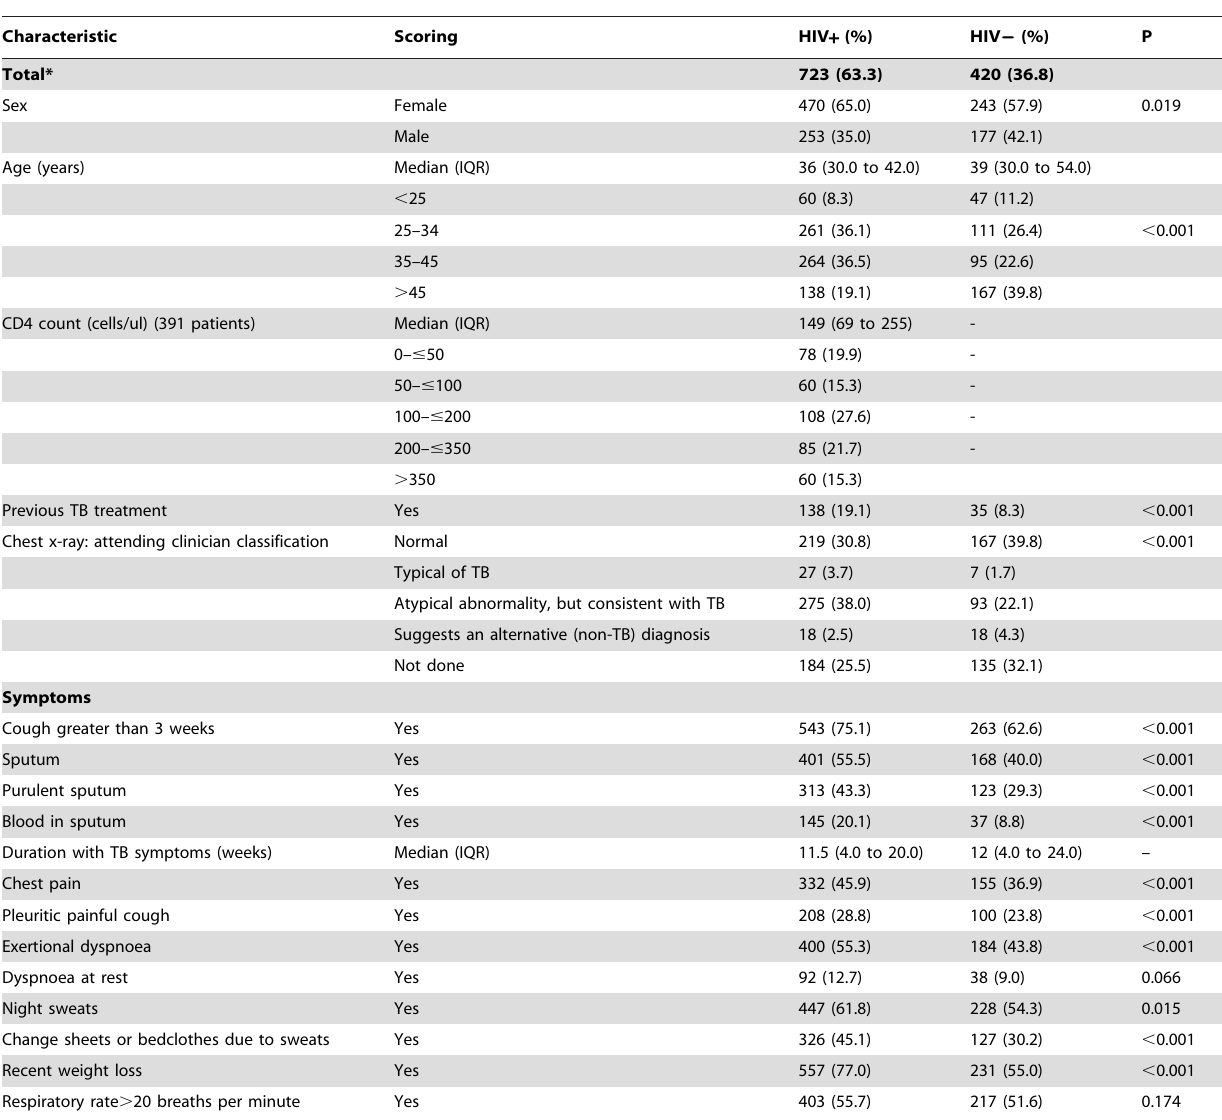
Table 1. Baseline characteristics and symptoms of smear-negative TB suspects by HIV